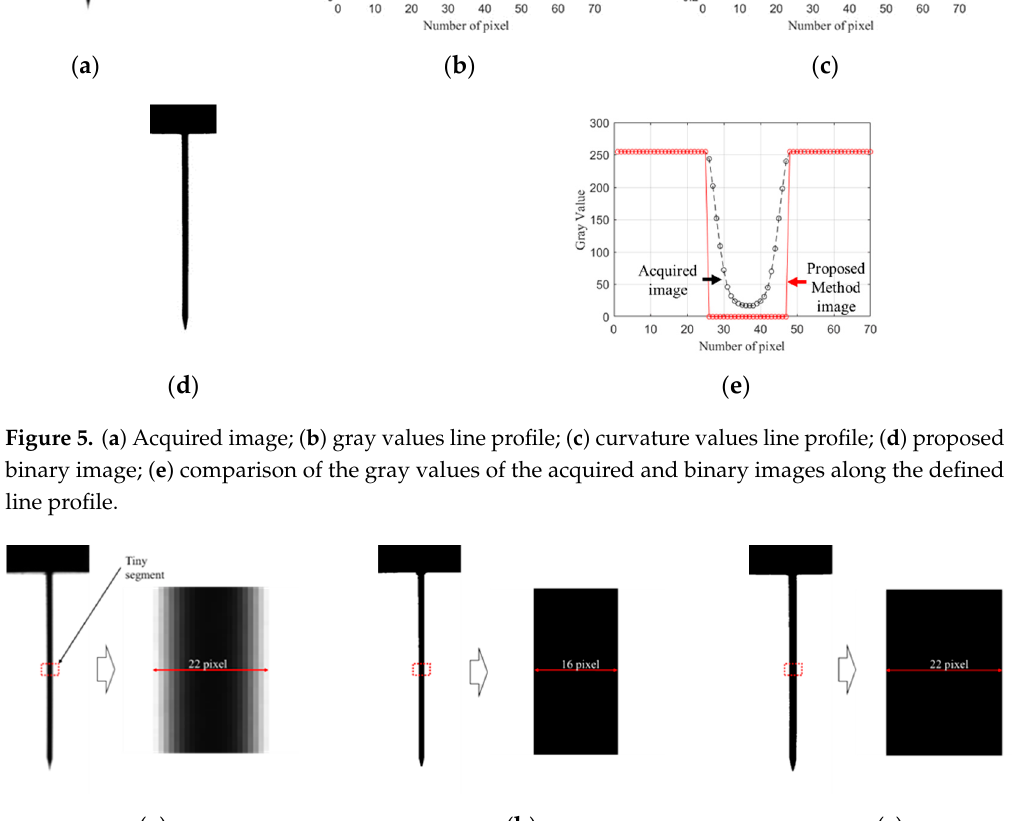
Figure 5. ( a ) Acquired image; ( b ) gray values line profile; ( c ) curvature values line profile; ( d )